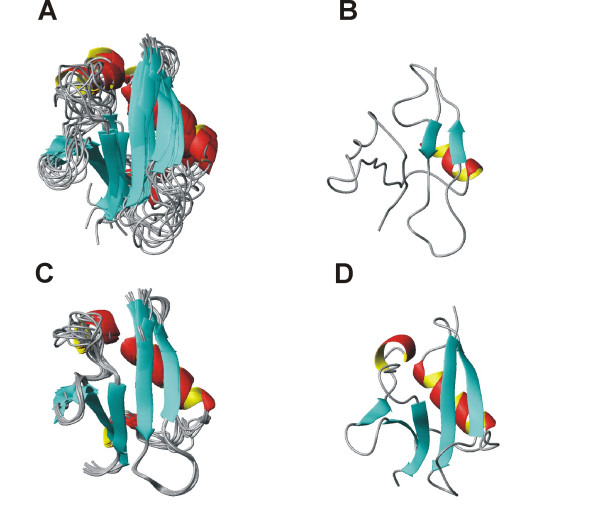
Improvement of the solution structure of RalGDS-RBD by an X-ray structure of the same molecule in complex with Ras. Upper Panel: (A) Newly calculated low resolution NMR structural bundle of RalGDS-RBD. (B) Input X-ray structure of RalGDS obtained in complex with Ras. Lower Panel: (C) 10 final refined structures of RalGDS-RBD without refinement in explicit solvent. (D) Reference NMR structure created from a full set of experimental restraints (25 h-bonds, 104 Φ and Ψ dihedral angles, and 1550 NOEs).